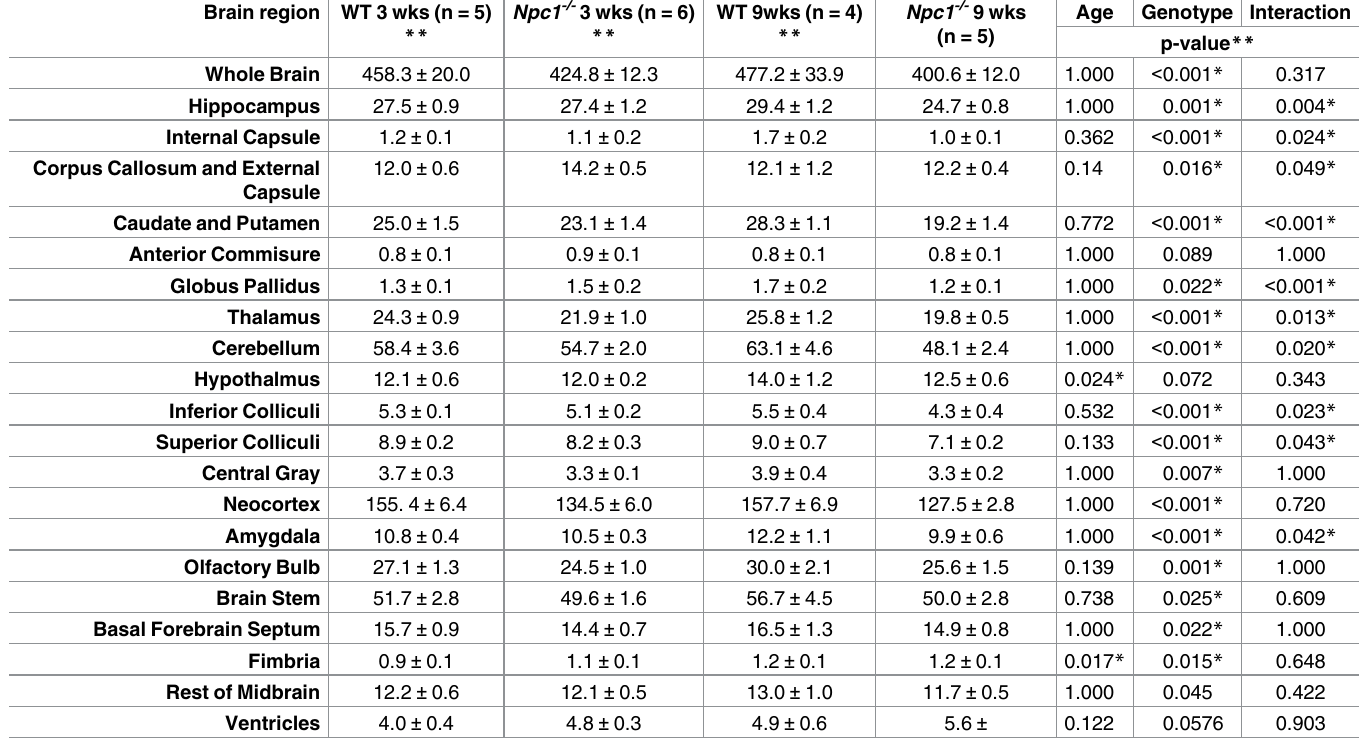
Table 1. Brain region volume * , effects and interactions in 3 and 9 week old Npc1 -/- and control mice. Brain region WT 3 wks (n = 5)